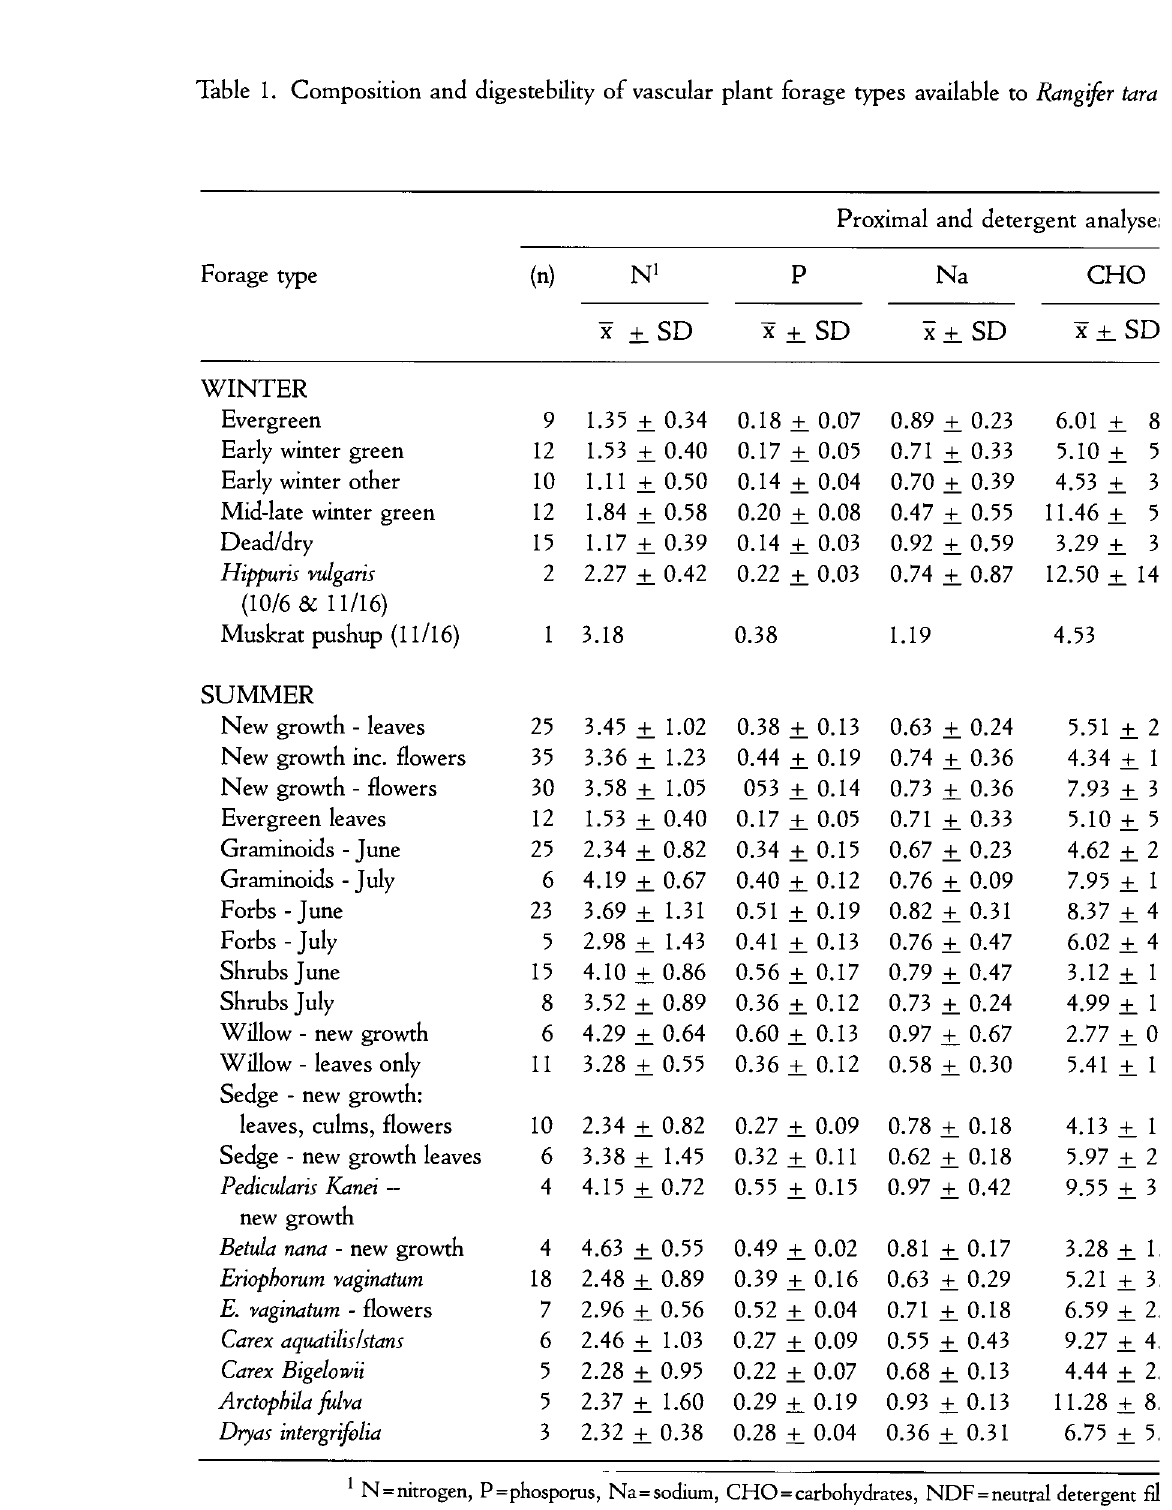
Proximal and detergent analyse: